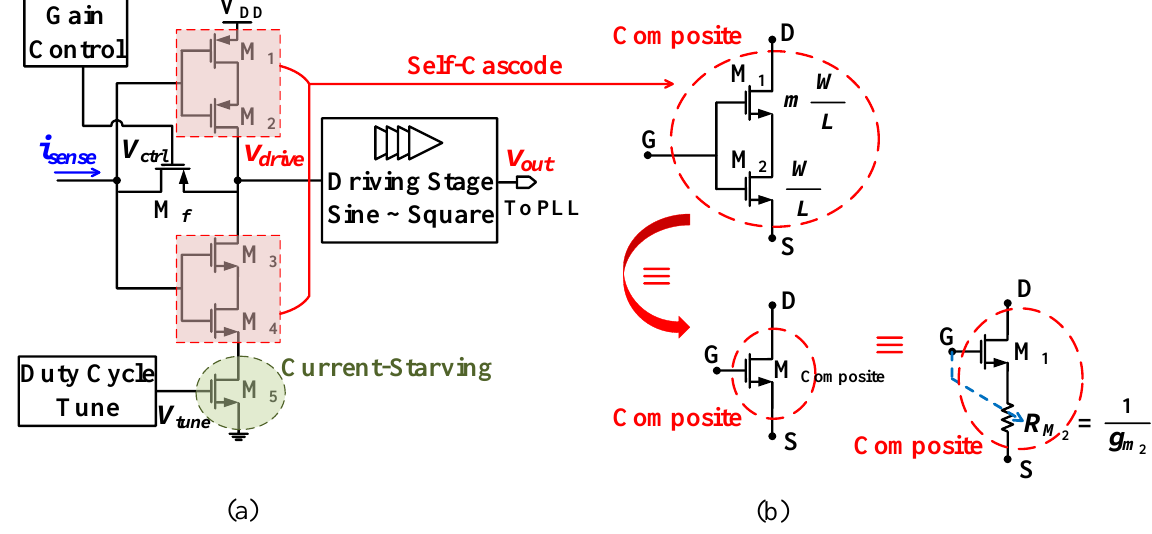
Figure 6. Proposed TIA circuit diagram: ( a ) one half of the differential signal path for simplicity and ( b ) self-cascode composite